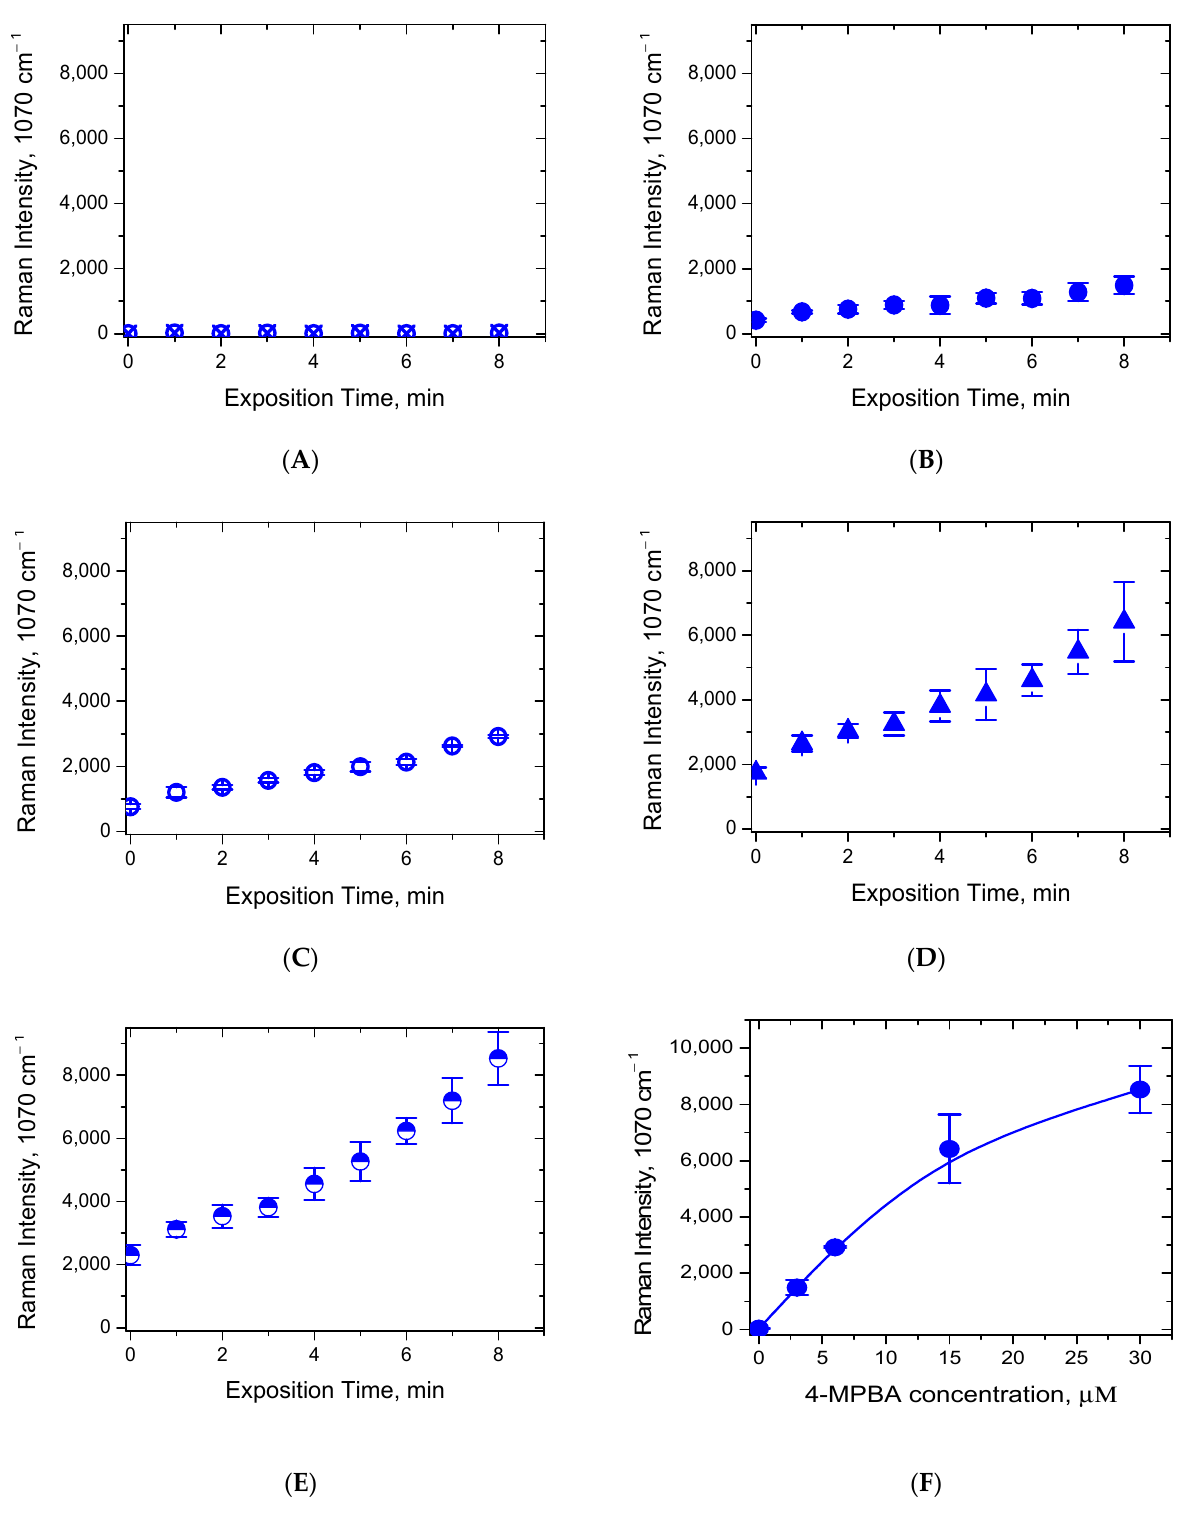
Figure 6. ( A – E ) The intensity increase in the 4-MPBA characteristic peak at 1070 cm − 1 upon 8 cycles of local laser exposure of a drop of the AgNPs/PB- b -PDMAEMA hybrid labeled with 4-MPBA at different 4-MPBA concentrations ( A ) 0 µ M (control with water), ( B ) 3 µ M, ( C ) 6 µ M, ( D ) 15 µ M, and ( E ) 30 µ M; ( F ) the dependence of the intensity of characteristic peak at 1070 cm − 1 on 4-MPBA concentration plotted for the laser exposure time equal to 8 min. The data are presented as the mean ± SD for three independent experiments.